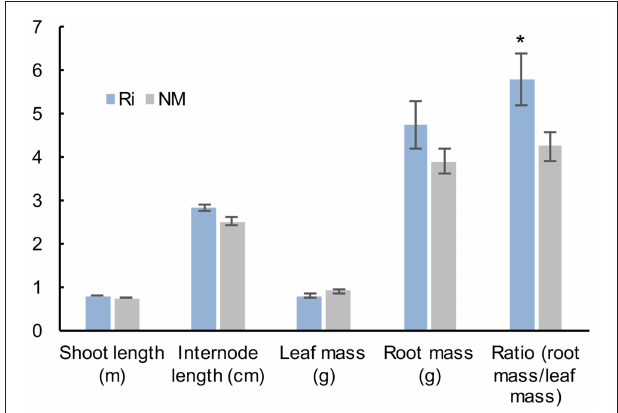
FIGURE 1 | Plant growth parameters of grapevine wood cuttings inoculated (Ri) or not (NM) with R. irregularis. Shoot length, internode length, mass of the seven first leaves, and whole root system mass (fresh weights) were measured 2 months after mycorrhization. Results are means ± SE of 12 biological replicates. Asterisks indicate significant difference between NM and Ri condition (Kruskall and Wallis, p < 0.05).